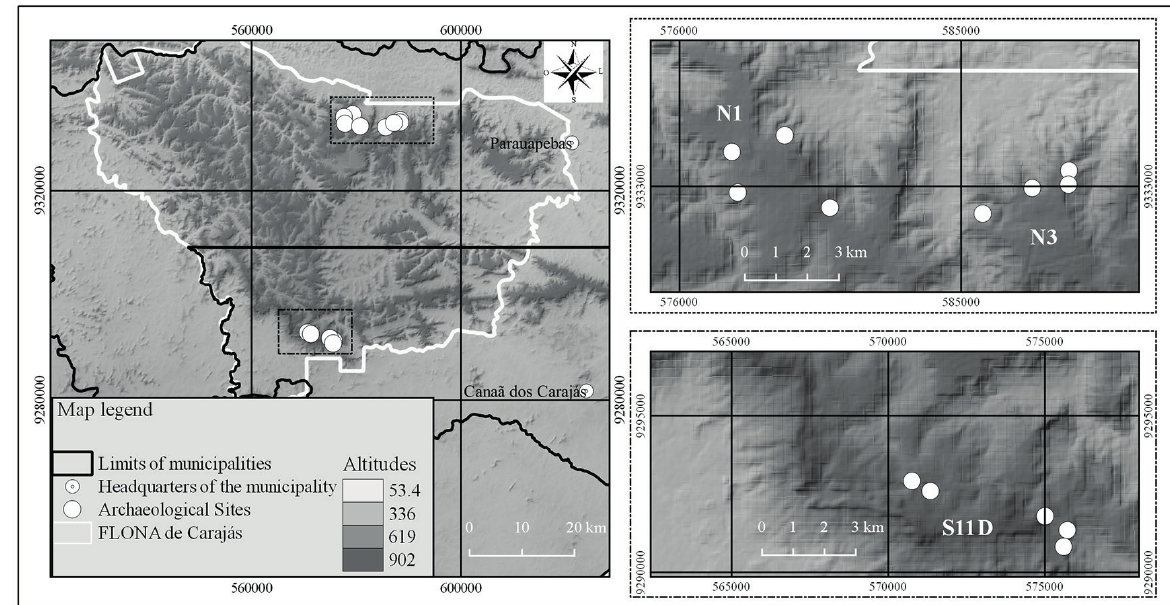
Figure 1 - Location map of the sites inventoried in plateaus N1 and N3 (Serra Norte) and S11D (Serra Sul), Carajás National Forest (FLONA de Carajás), Pará, Brazilian Amazon. By Carlos Barbosa,